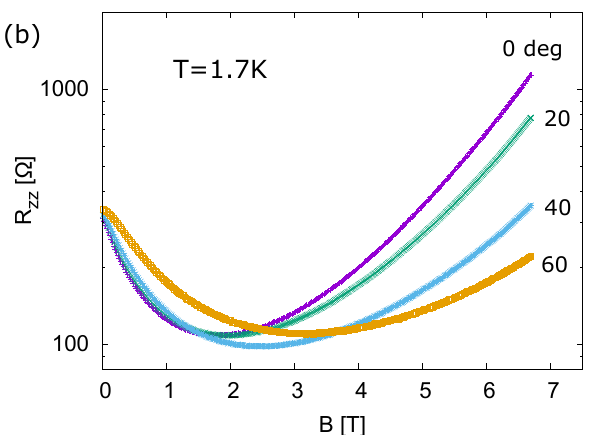
Figure 3. ( a ) theoretical results on B -dependences of ρ zz for θ = 0 (solid line), 20 (dotted line), 40 (dashed line), and 60 ◦ (dot-dashed line) at T = 1.7 K. ( b ) experimental results on B -dependences of R zz for θ = 0, 20, 40, and 60 ◦ at T = 1.7 K.